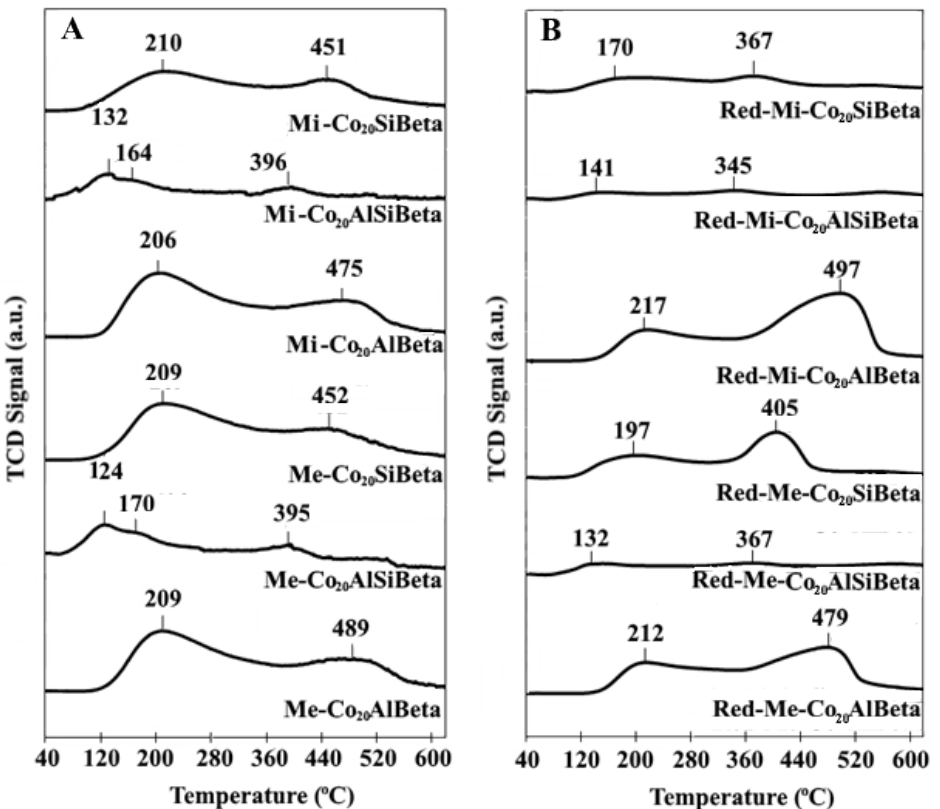
Figure 6. NH 3 -TPD profiles of ( A ) Me-Co 20 AlBeta, Me-Co 20 AlSiBeta, Me-Co 20 SiBeta, Mi-Co 20 AlBeta, Mi-Co 20 AlSiBeta and Mi-Co 20 SiBeta and ( B ) Red-Me-Co 20 AlBeta, Red-Me-Co 20 AlSiBeta, Red-Me-Co 20 SiBeta, Red-Mi-Co 20 AlBeta, Red-Mi-Co 20 AlSiBeta and Red-Mi-Co 20 SiBeta.